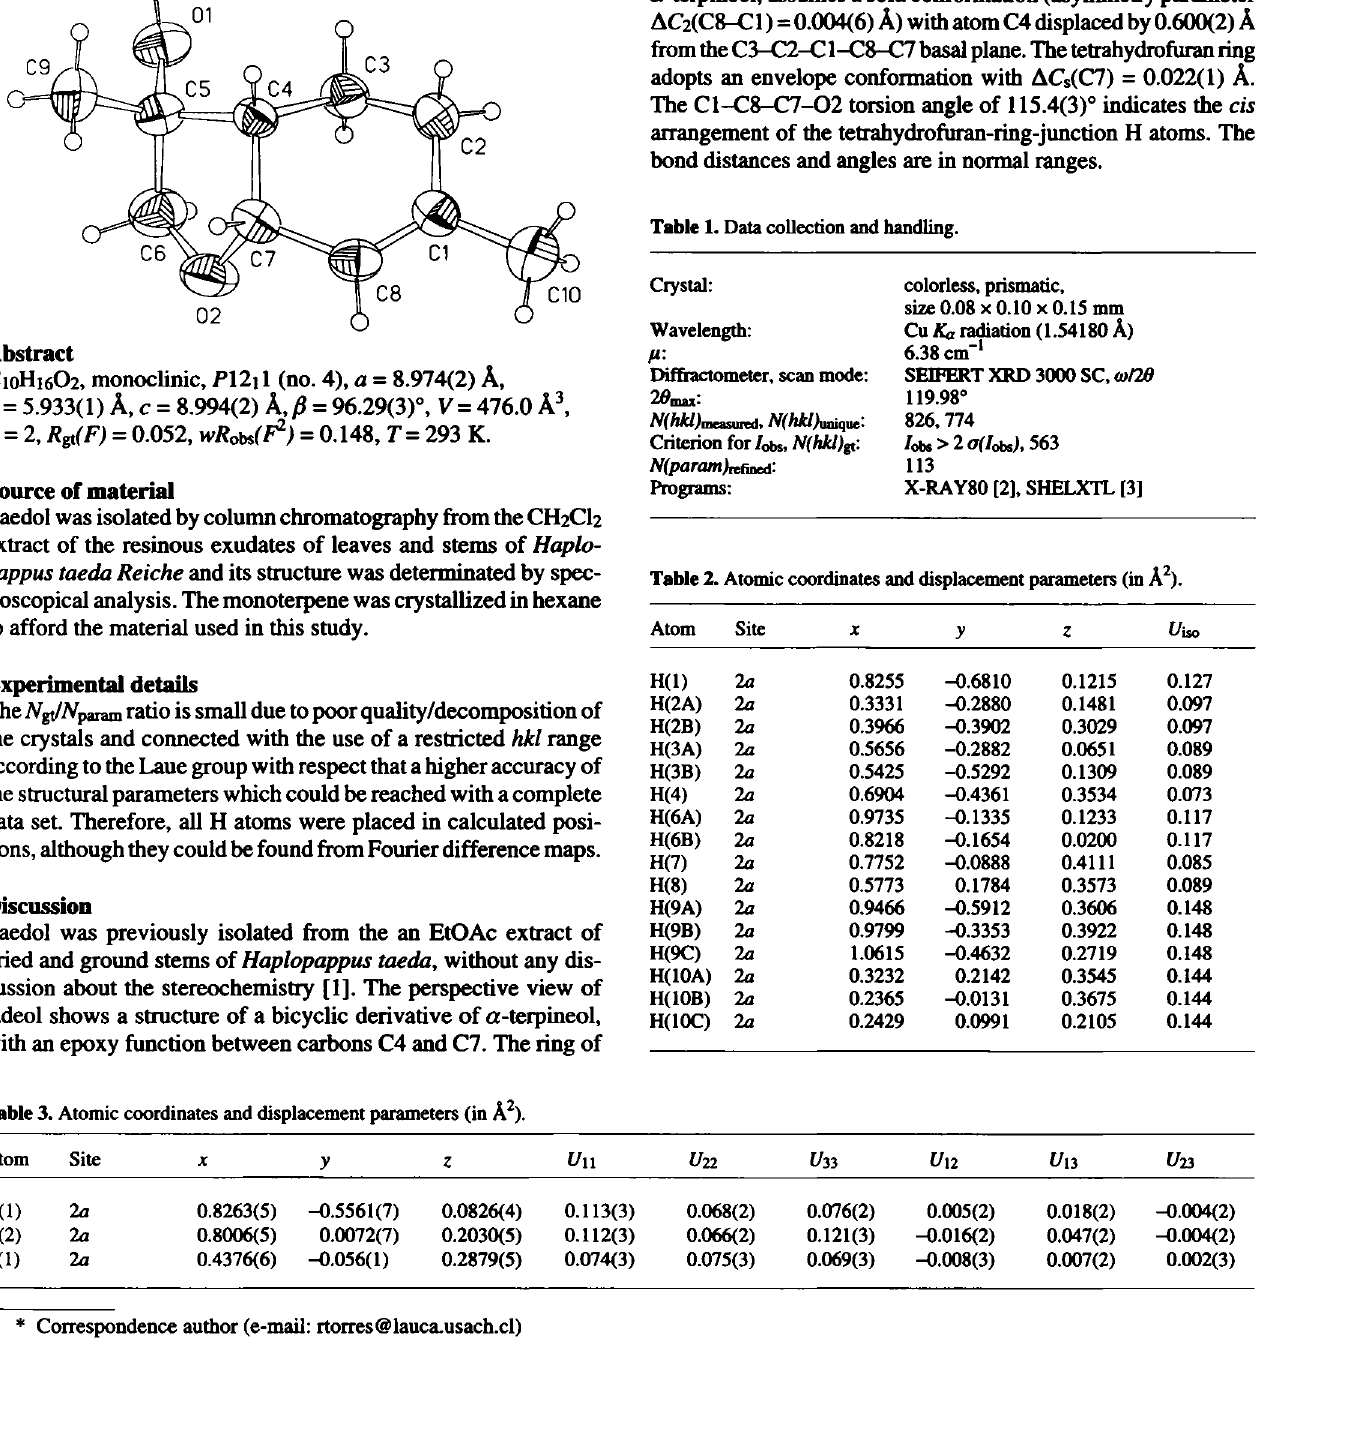
Table 1. Data collection and handling.